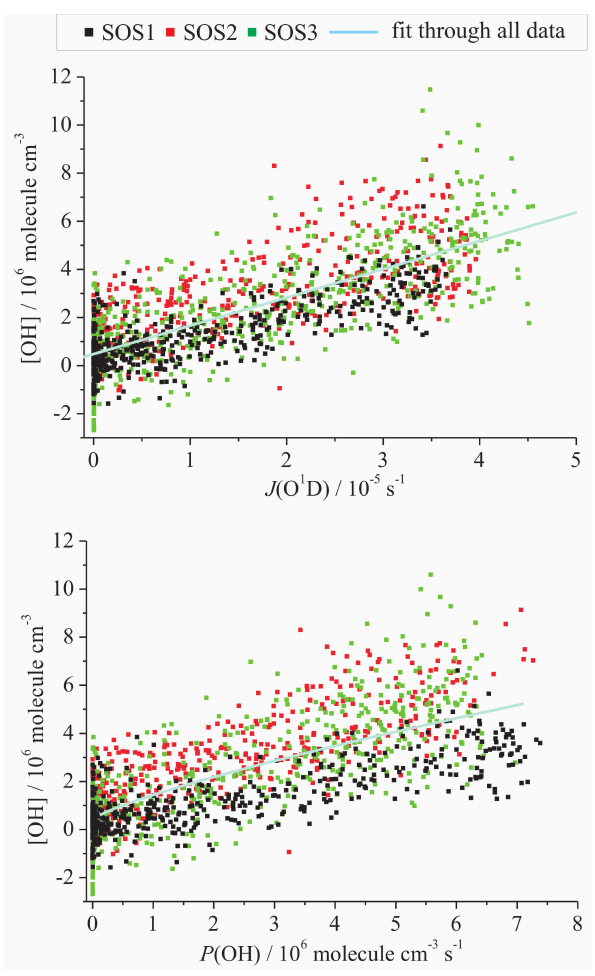
Fig. 7. Plots of five-minute averaged [OH] as a function of J (O 1 D) (upper) and P (OH) (lower). Data from SOS1–3 are represented by black, red and green squares, respectively, and the blue lines are the results of the non-linear fits to the complete datasets.